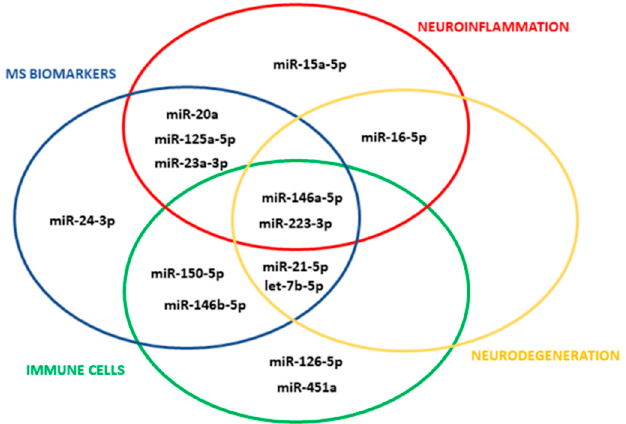
Figure 1. miRNA selection. The Venn diagram shows the 14 circulating miRNAs with validated synaptic targets which meet the selection criteria.